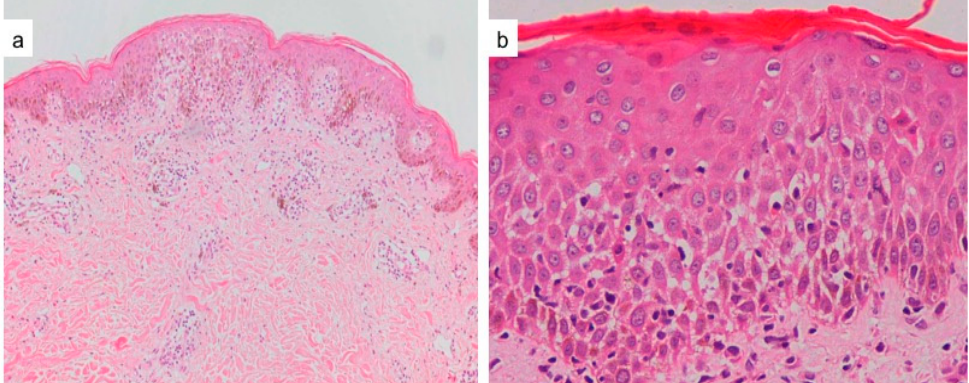
Figure 3. ( a ) Drug exanthem to tranexamic acid, showing spongiosis, focal vacuolar interface changes with papillary dermal perivascular and interstitial infiltration of lympho-histiocytes and eosinophils (H&E ×40). ( b ) Drug exanthem to rifampicin, showing parakeratosis, spongiosis, necrotic keratinocytes in upper layers of the epidermis, lymphocytic exocytosis and papillary dermal infiltration of lymphocytes and eosinophils (H&E ×400).